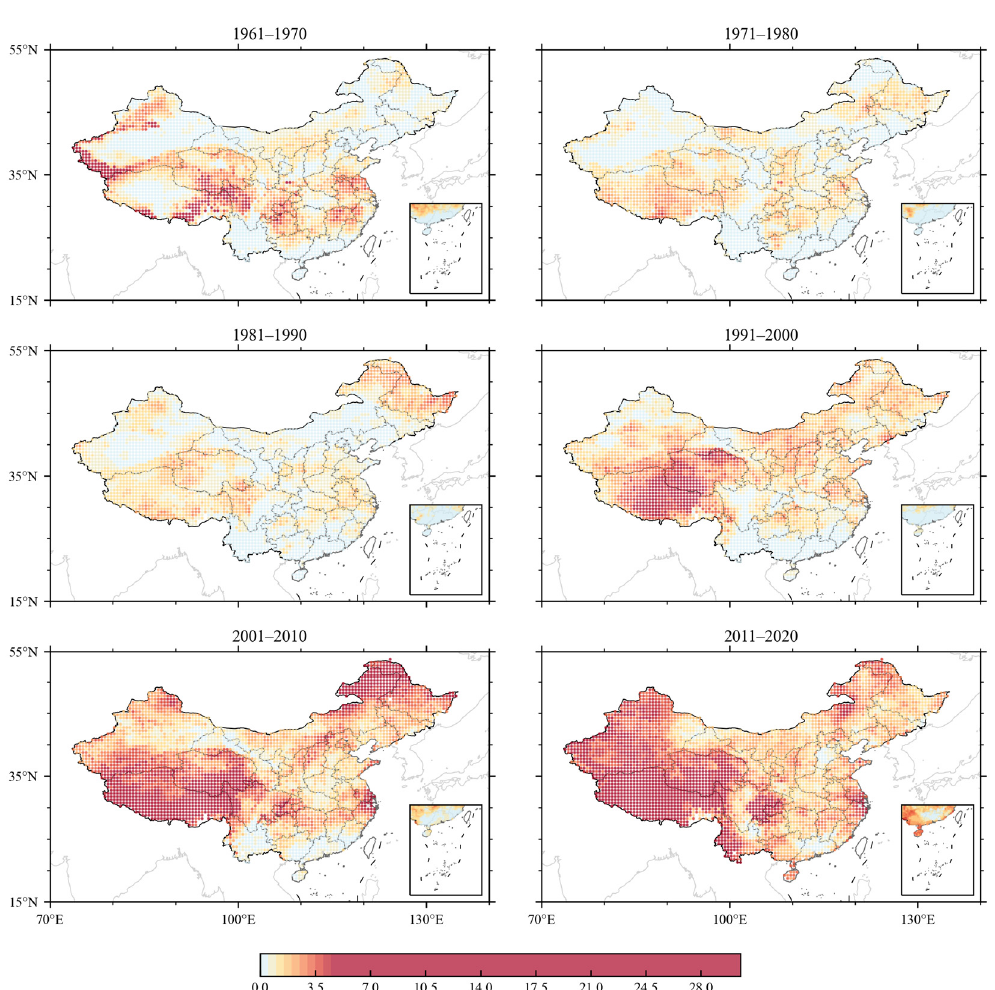
Figure 12. Distribution diagram of average days of heat waves in decades based on VATM.